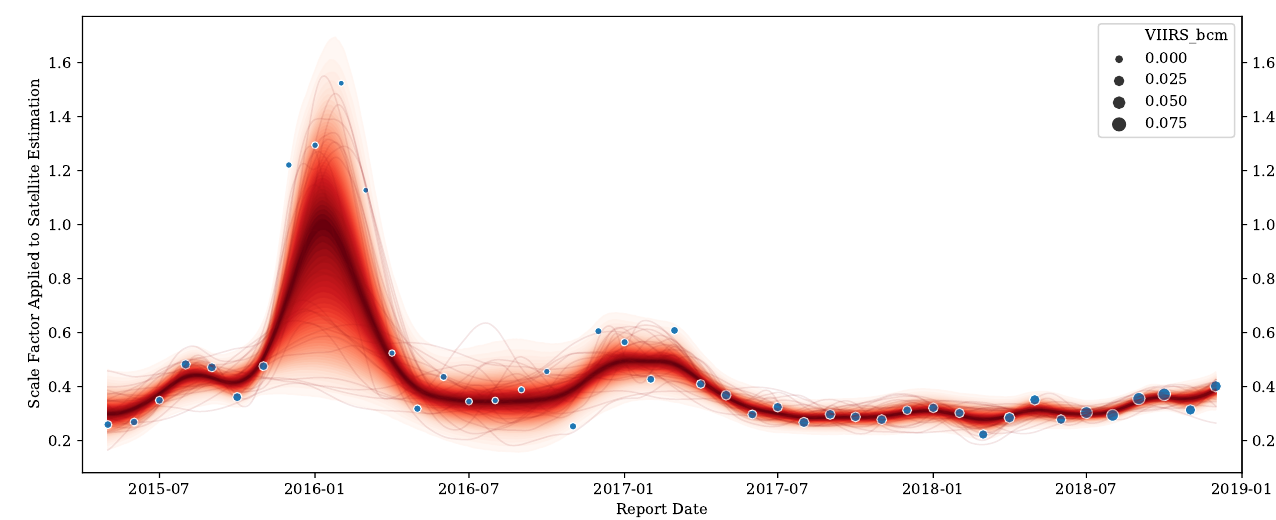
Figure 13. Posterior predictive samples showing the scale factor variations in the Blue Buttes Field. Blue points stand for the observed data while red lines denote thirty posterior samples. Larger points indicate greater flaring magnitude as observed by VIIRS.